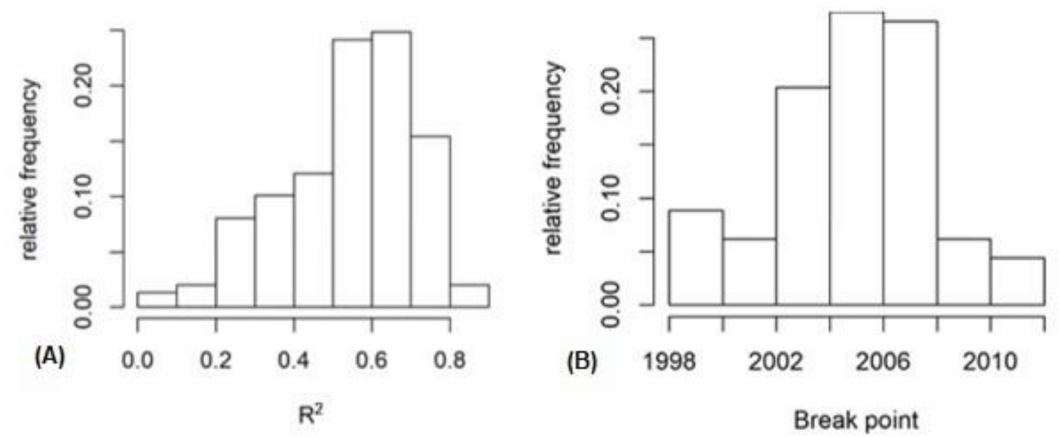
Figure 4. ( A ) The histogram of relative frequency of the coe ffi cient of determination R 2 for the 154 water quality monitoring stations. ( B ) The histogram (relative frequency) of the breakpoint for the studied 154 water quality monitoring stations, using flow-normalized concentrations with removal of all random variations.